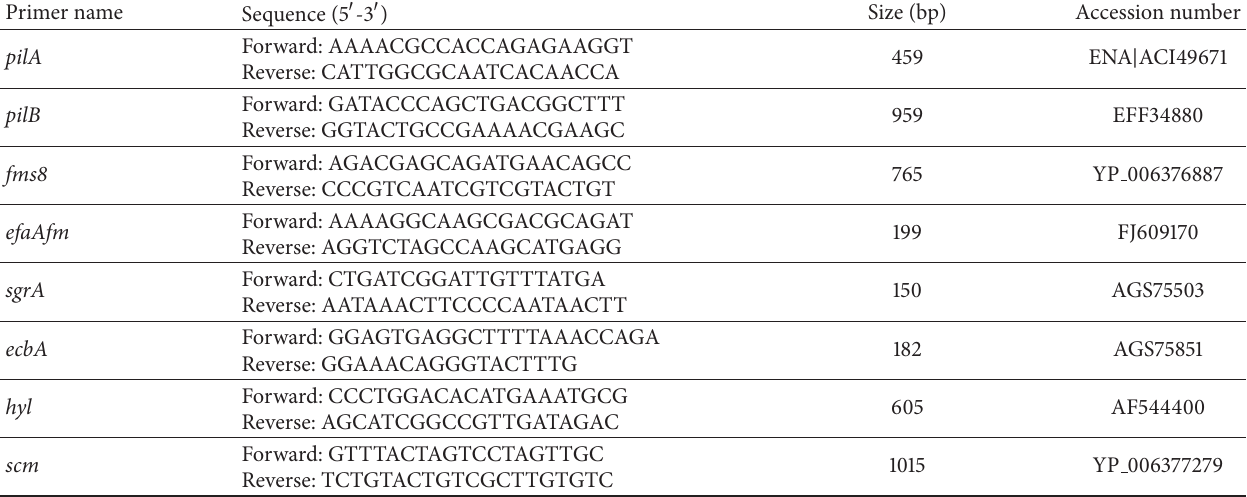
Table 1: Characteristics of different primers used in the current